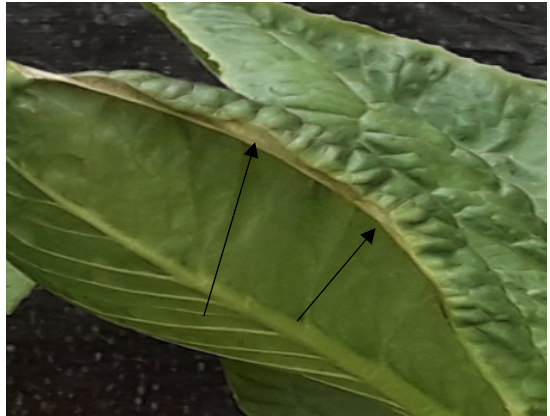
Table 2. Effect of Piriformospora indica, Glomus mosseae , and Glomus etunicatum on the stomata pore area (µm 2 ) under different concentrations of DCD in lettuce. Figure 10. Effect of dicyandiamide on appearance of